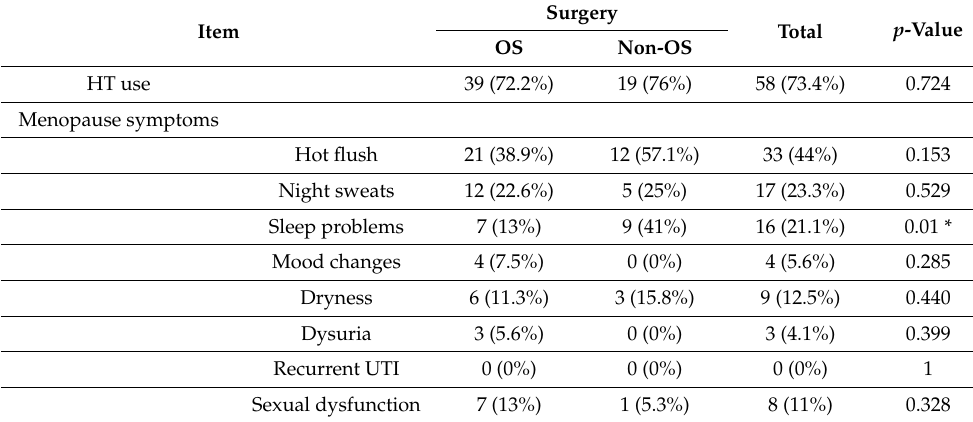
Table 2. Menopause characteristics of the